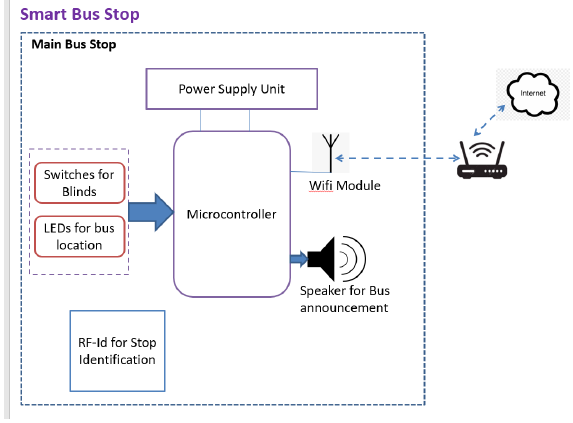
Figure 2. Block Diagram of System Created for Bus